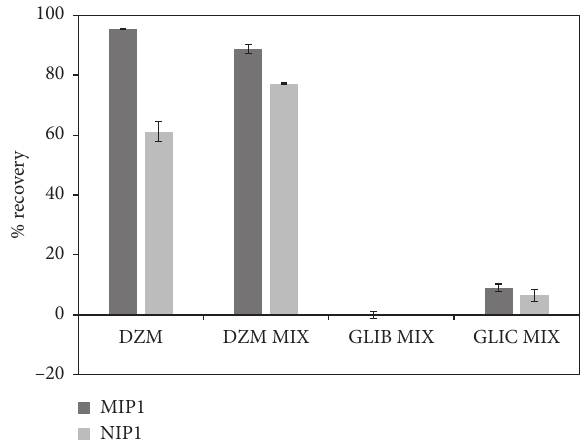
Figure 4: Percent recovery of DZM (alone and in a mixed solution of GLIB and GLIC). The error bars represent the standard deviation of three separate sample runs ( n �